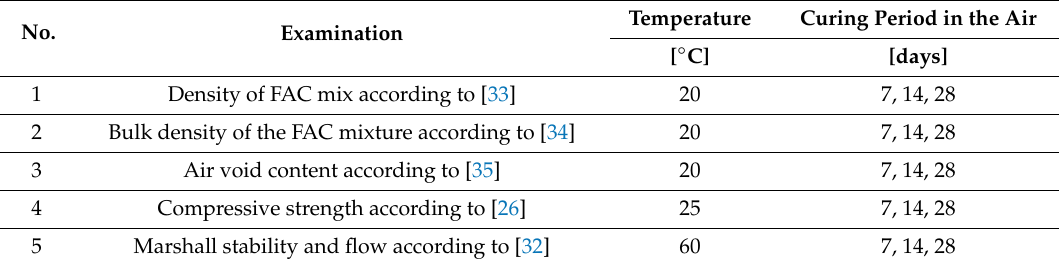
Table 3. Laboratory research program.